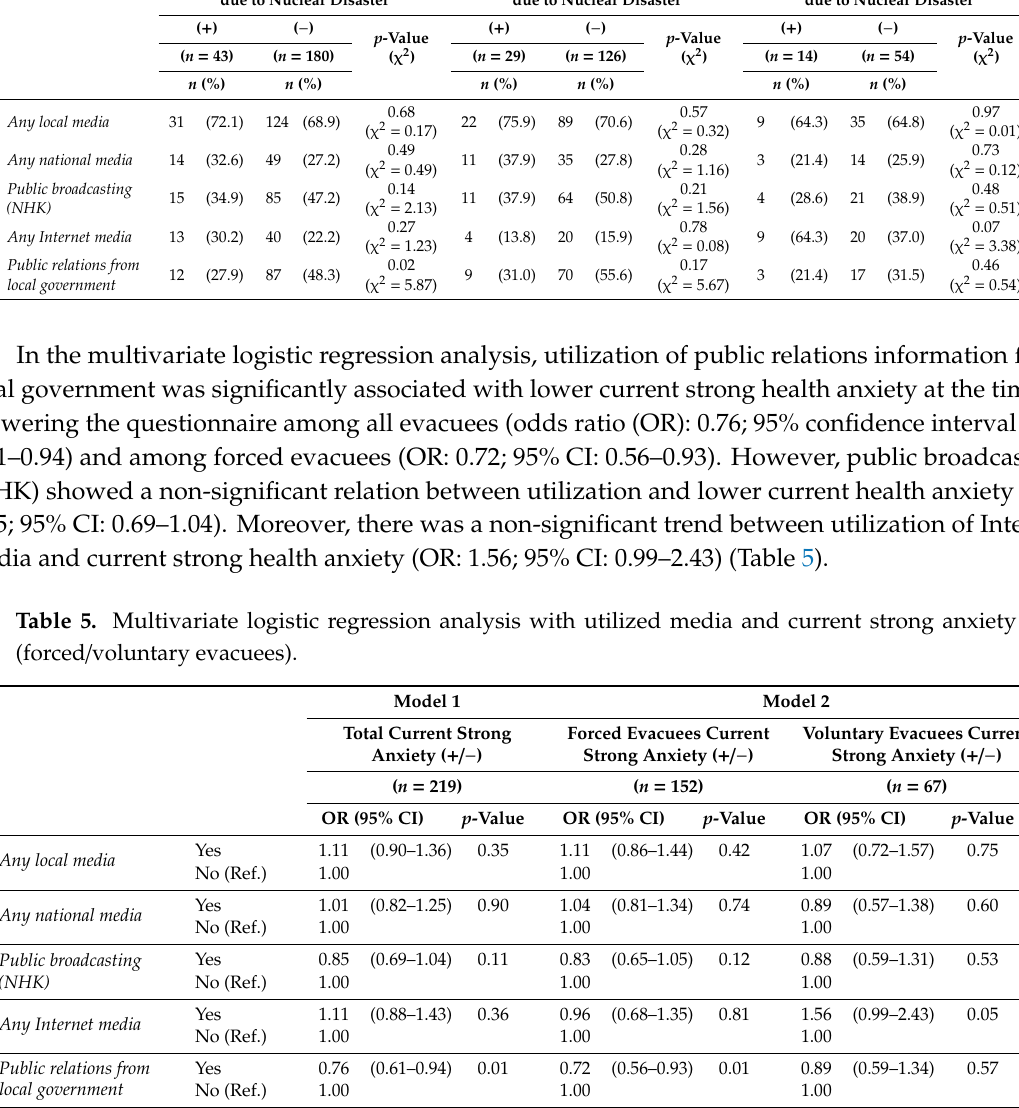
Table 4. Association between current strong anxiety and media utilization (forced / voluntary evacuees). Total Forced Evacuees Voluntary Evacuees Current Strong Anxiety about Health due to Nuclear Disaster